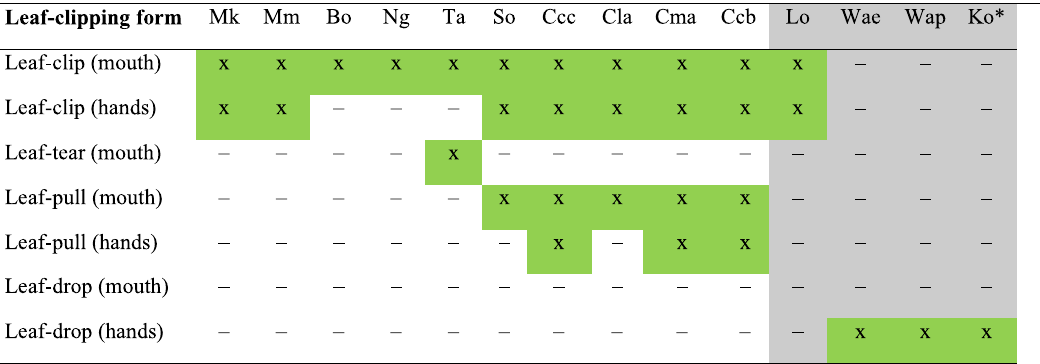
Table 1. Leaf-modifying gesture forms described in different communities of chimpanzees and bonobos in the current literature. “X” in a green cell indicates this behaviour is confirmed in the community “–” indicates behaviour is not confirmed. White columns and grey columns indicate chimpanzee and bonobo communities, respectively. * Codes for each community: Chimpanzees. Mk = K group, Mahale, United Republic of Tanzania 2 . Mm = M group, Mahale, United Republic of Tanzania 20 . Bo = Bossou, Bossou, Republic of Guinea 21 . Ng = Ngogo, Kibale, Republic of Uganda 22 . Ta = South Group, Taï, Republic of Côte d’Ivoire 19,25 . So = Sonso, Budongo, Republic of Uganda 29 . Ccc = Caiquene-Cadique group, Cantanhez National Park, Republic of Guinea-Bissau 20 . Cla = Lautchandé group, Cantanhez National Park, Republic of Guinea-Bissau 20 . Cma = Madina group, Cantanhez National Park, Republic of Guinea-Bissau 20 . Ccb = Cambeque group, Cantanhez National Park, Republic of Guinea-Bissau 20 . Bonobos. Lo = Eyengo community, Lomako, Democratic Republic of the Congo 17 . Wae = E1 community, Wamba, Democratic Republic of the Congo 26 . Wap = P community, Wamba, Democratic Republic of the Congo 28 . Ko = Kokoalongo, Ekalakala, and Fekako communities, Kokolopori, Democratic Republic of the Congo –* data are for one population that included three communities 29